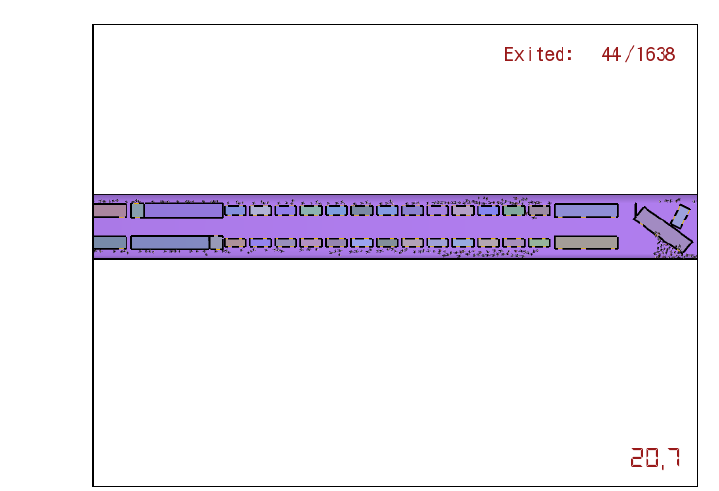
Figure 7 – The simulation example for the noted case after 20.7 seconds from the start of the simulation Рис . 7 – Симуляционный пример приведенного случая спустя 20.7 секунд от начала симуляции